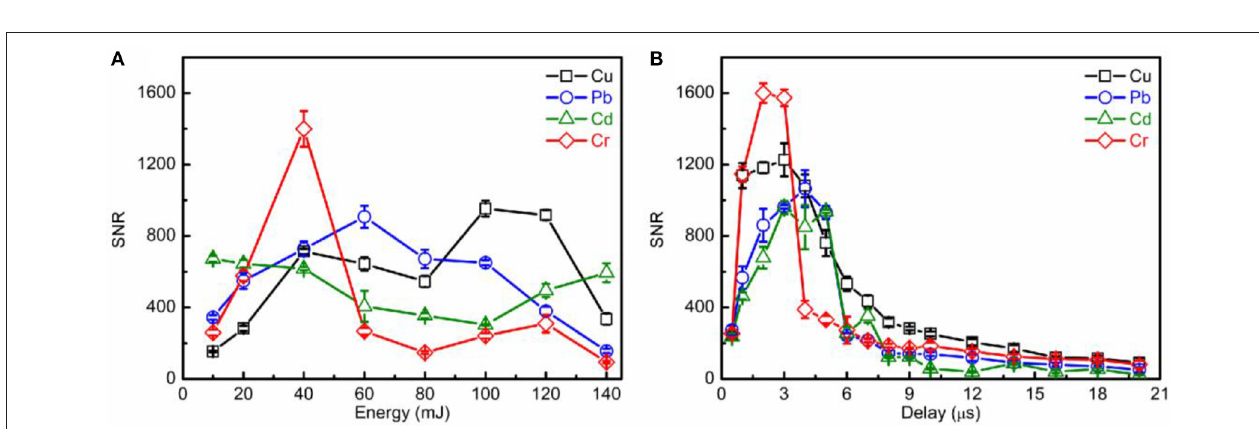
FIGURE 2 | Optimization of sample preparation conditions: the effect of sample volume on the spectral intensity (A) ; the drying temperature on the drying time (B) .